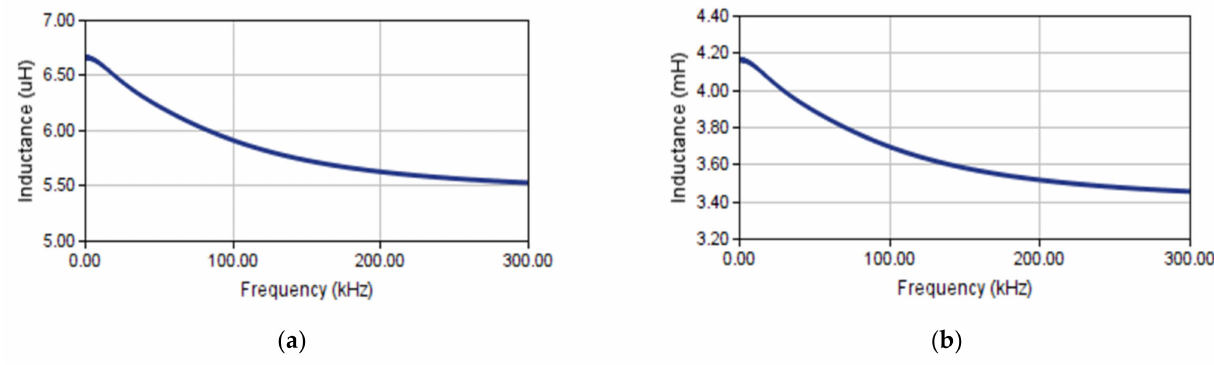
Figure 16. Leakage Inductance of toroidal transformer ( N p = 15 & N s = 375). ( a ) Primary winding, ( b ) Secondary winding.